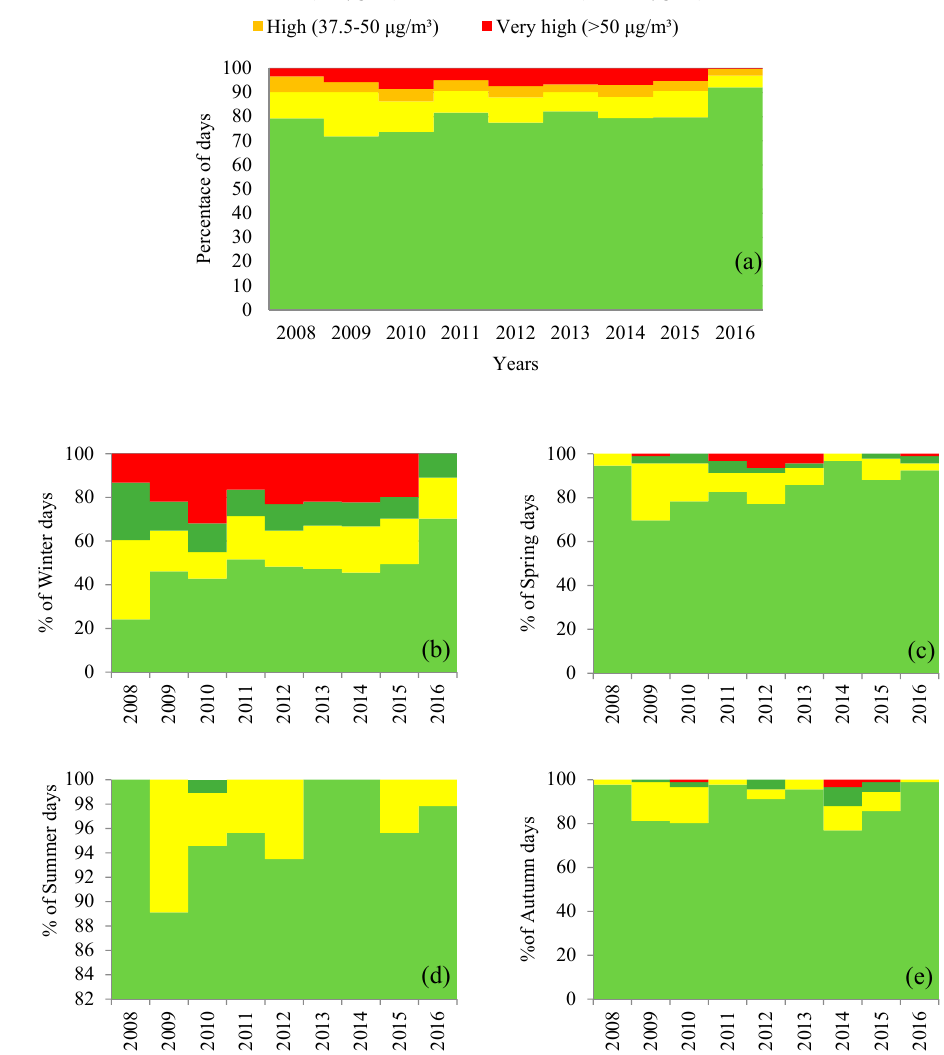
010203040 0100200300400500600700